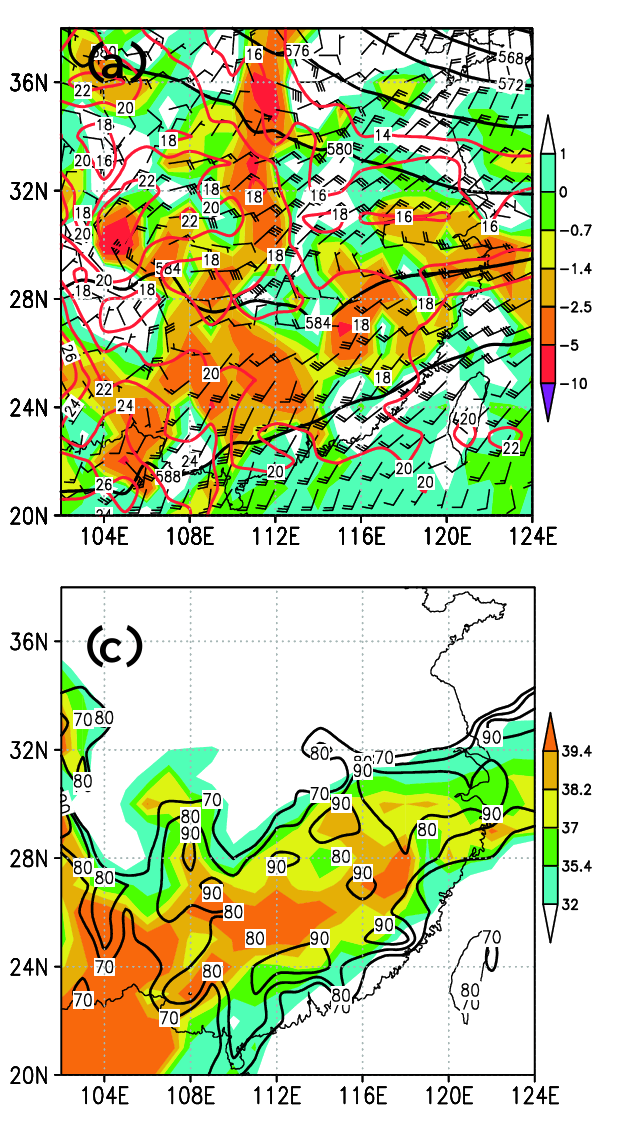
Figure 9. The 48-h synoptic pattern and parameter distribution valid at 20:00 BT on 15 May 2015 provided 48 h in advance by the NCEP GFS dataset; ( a ) 925 hPa divergence (10 − 5 s − 1 , negative shading with legend at right), 850 hPa wind field (where a half-bar represents 2 m s − 1 , a full bar represents 4 m s − 1 , and a flag represents 20 m s − 1 ), temperature (red line, ◦ C), and 500 hPa isobars (solid black line). ( b ) The PWAT (shaded with legend at right) and BLI (dashed black lines, ◦ C). ( c ) The KI (shaded with legend at right) with the 850 hPa relative humidity greater than 70% (black solid line, %).